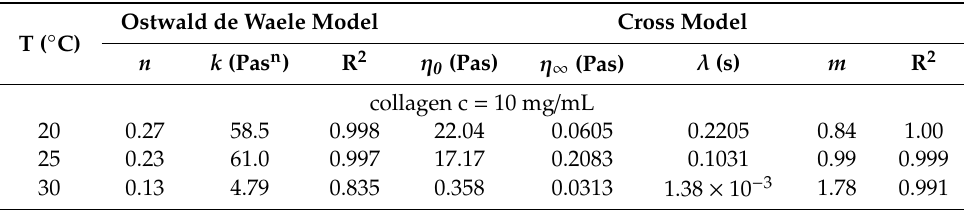
Table 3. The rheological parameters from Ostwald de Waele model and Cross model for collagen solution after 15 min of UV irradiation versus temperature.